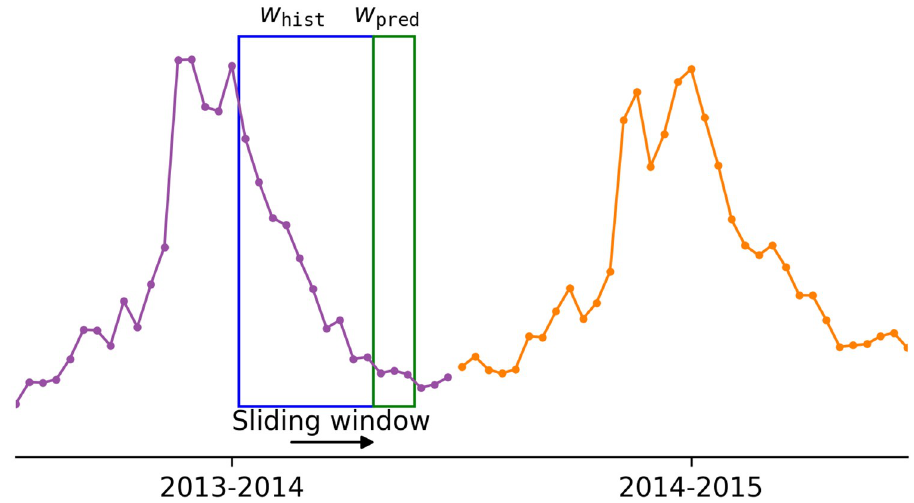
Fig 5. CA %ILI curve. An example illustration of applying a sliding window to a %ILI curve of California from the 2013–2014 season to the 2014–2015 season.